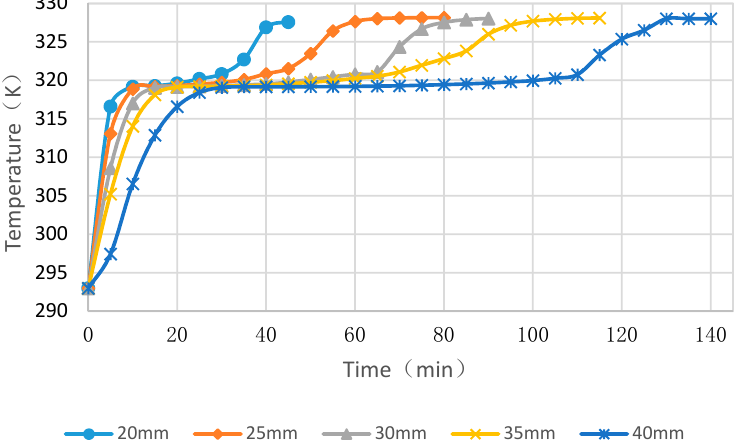
Figure 11. PCM cylinder module melting times for different diameters when the hot water temperature is 55 °C.